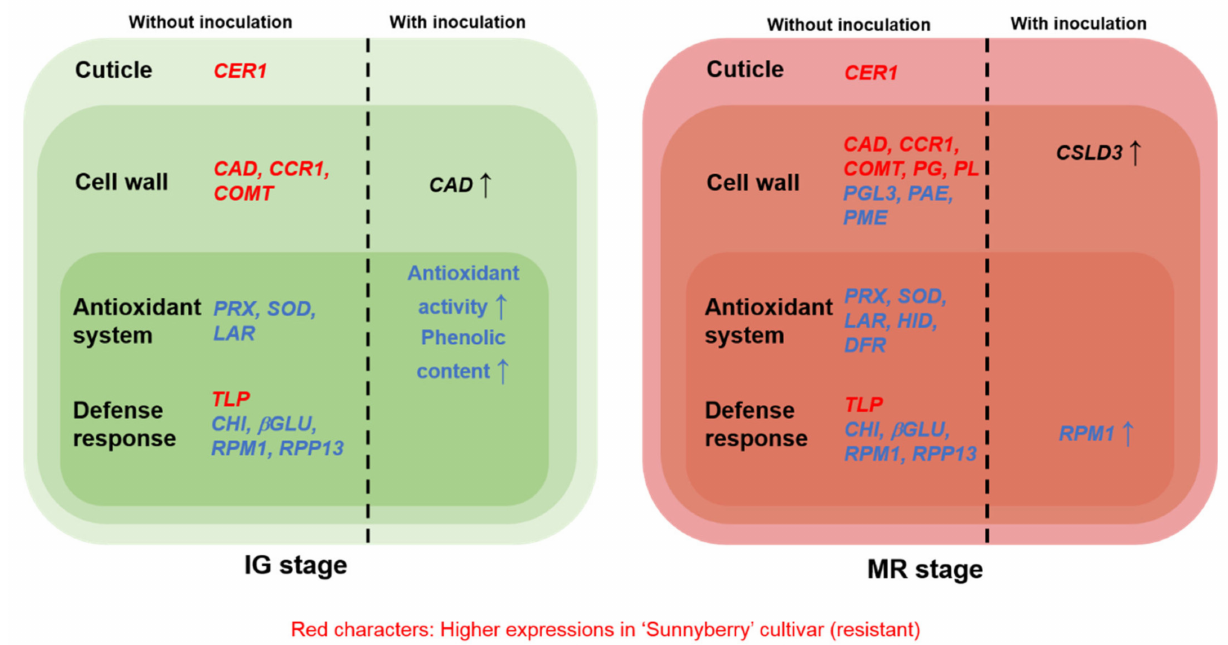
Figure 7. Differences between cultivars at IG and MR in terms of gene expression and defense responses against Botrytis cinerea . β GLU , glucan endo-1, 3- β -glucosidase; CAD , cinnamyl alcohol dehydrogenase; CCR1 , cinnamoyl-CoA reductase 1; CER1 , protein ECERIFERUM 1; CHI , chitinase; COMT , caffeic acid O -methyltransferase; CSLD3 , cellulose synthase- like protein D3; DFR , dihydroflavonol 4-reductase; HID , 2-hydroxyisoflavanone dehydratase; IG, immature-green; LAR , leucoanthocyanidin reductase; MR, mature-red; PAE , pectin acetylesterase; PG , polygalacturonase; PGL3 , polygalacturonase 1 β -like protein 3; PL , pectate lyase; PME , pectin methylesterase; PRX , peroxiredoxin; RPM1 , disease resistance protein RPM 1-like; RPP13 , disease resistance protein RPP 13-like; SOD , superoxide dismutase; TLP , thaumatin-like